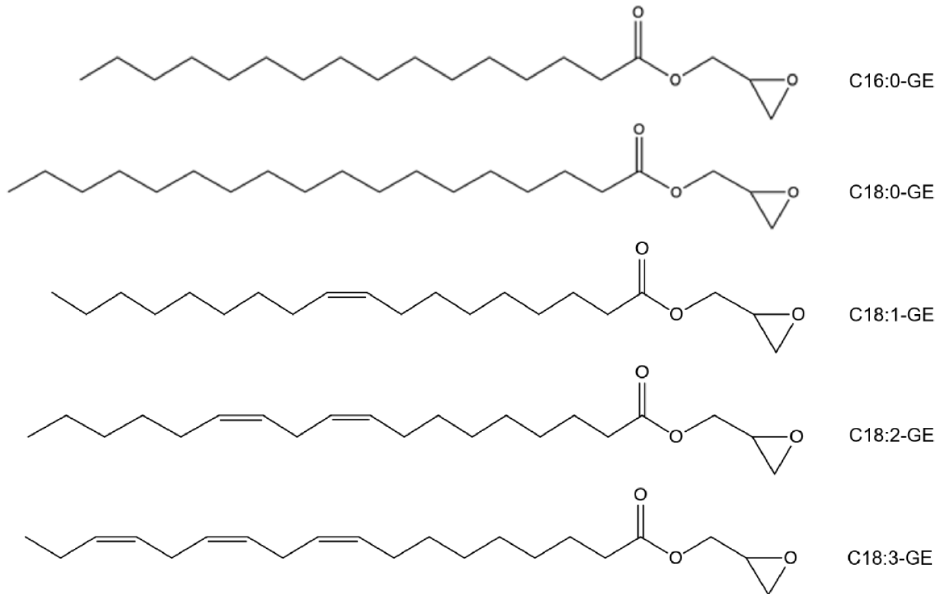
Figure 1. Chemical structures of five glycidyl ester (GE)